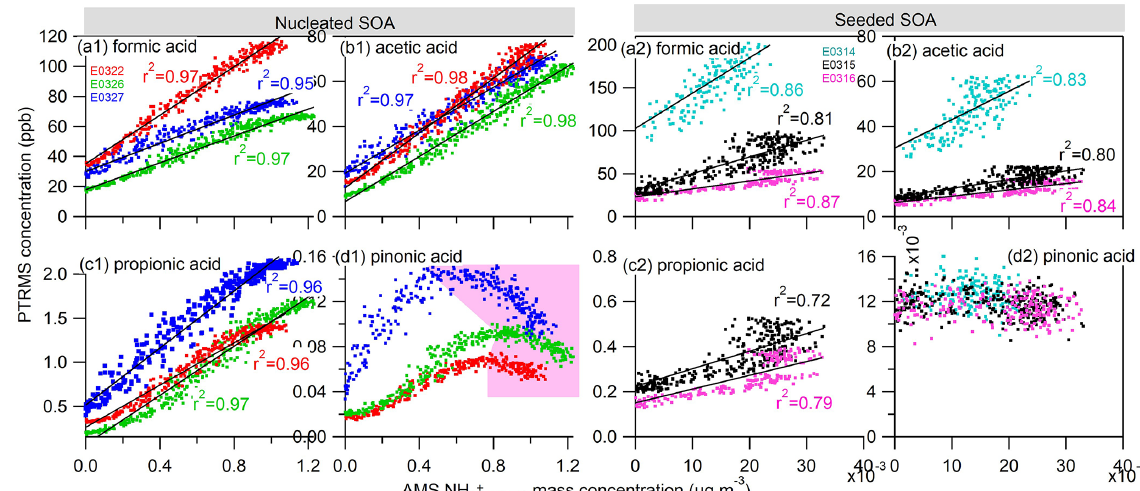
) in the particle phase by AMS to 4 , orgacid